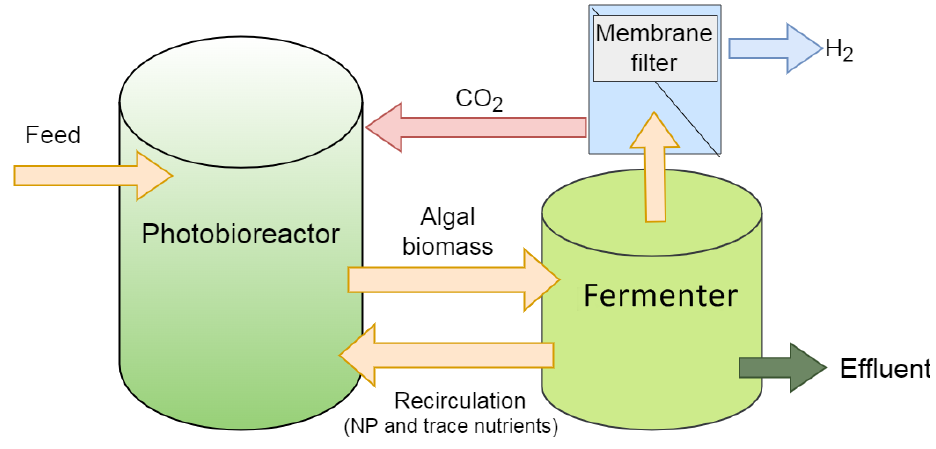
Figure 4. Closed-loop effluent treatment [36].